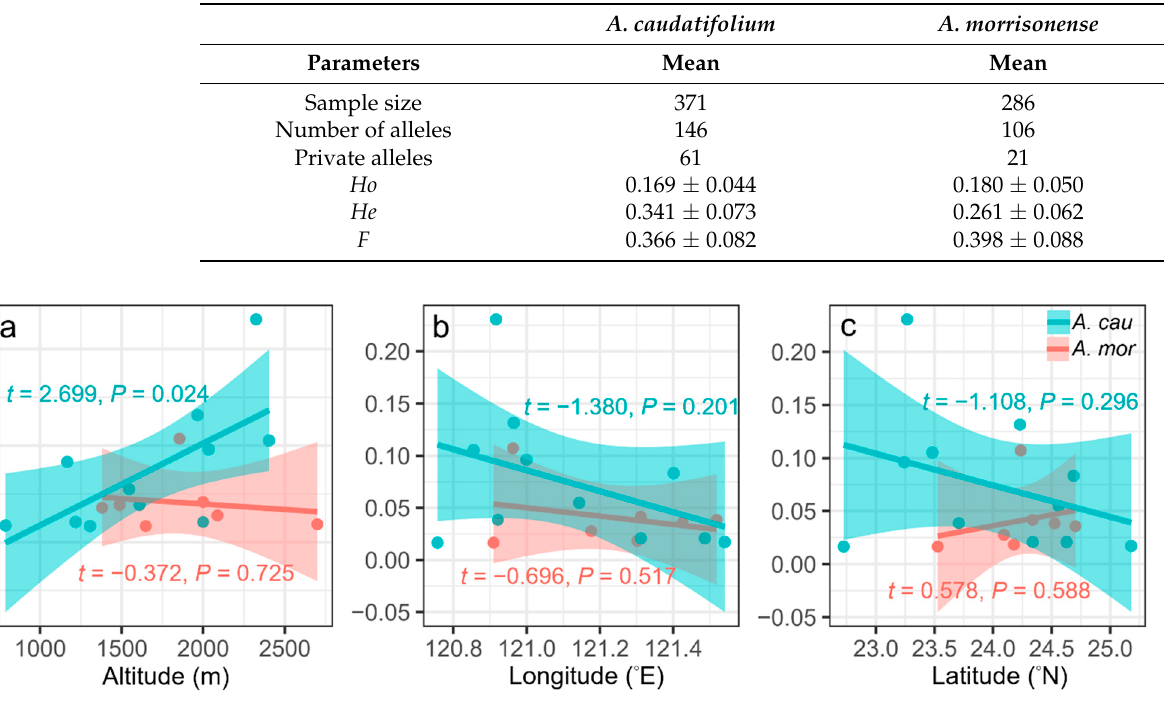
Figure 4. Geographic relationship with the private allele frequency of populations. The private alleles were predicted by ( a ) altitude, ( b ) longitude, and ( c ) latitude using linear regression. Analysis of molecular variance showed a significant divergence between two species ( Φ CT = 0.478, p < 10 − 5 ) and among populations ( Φ SC = 0.149, p < 10 − 5 ) (Table 2). In terms of individual species, most genetic variation existed within populations (82.5% and 89.9% in A. caudatifolium and A. morrisonense , respectively), but there was still significant genetic differentiation between populations ( Φ ST = 0.175 and 0.101 in A. caudatifolium and A. morrisonense , respectively, Table 2). The significant population differentiation reflected the positive inbreeding coefficient estimates ( F ) in both species. Table 2. Analysis of molecular variance (AMOVA) between two maple species.